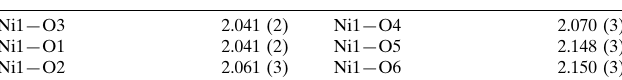
Selected bond lengths (A˚ ).